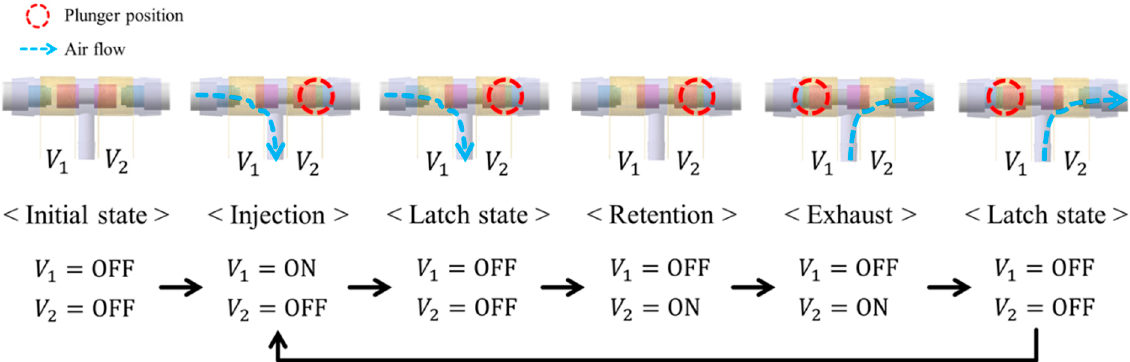
Figure 7. Operating process of the 3-way pneumatic valve.